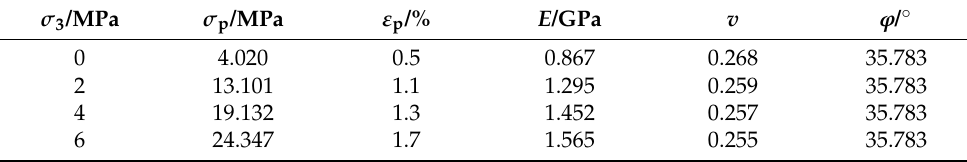
Table 2. Mechanical parameters of red sandstone under 5 freeze-thaw cycles.